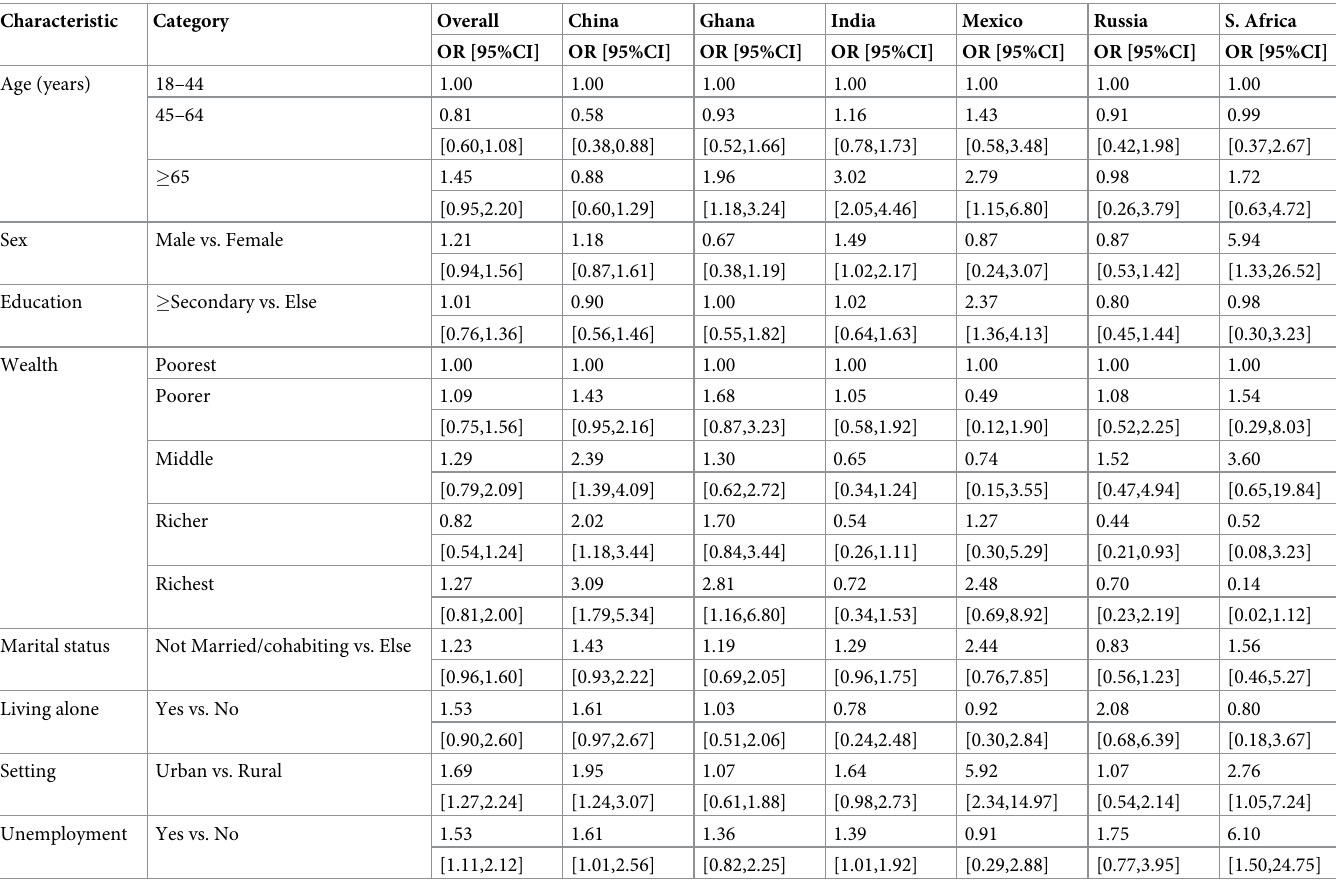
Table 2. Sociodemographic correlates of highly sedentary behavior a estimated by multivariable logistic regression (overall and by country). Characteristic Category